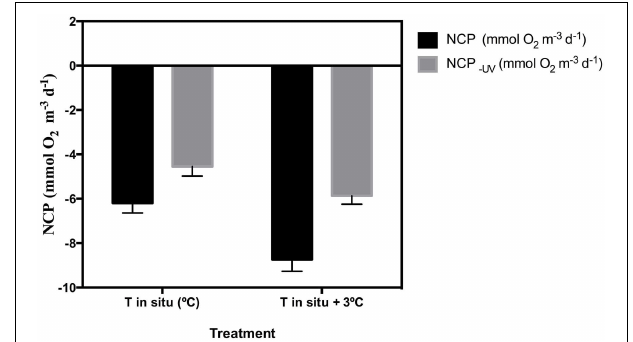
FIGURE 4 | Mean ( ± SE) for the five sampled months of NCP under full solar radiation and NCP − UV where UVR is excluded (mmol O 2 m − 3 d − 1 ) for the in situ temperature (control) and the warming treatment ( in situ plus 3 ◦ C). NCP being dependent of the incident UV-B radiation. The effect of UV-B on NCP is, thus, strongest in June, when UV-B reaches a maximum and declines along the summer, as NCP becomes more negative with increasing temperatures as